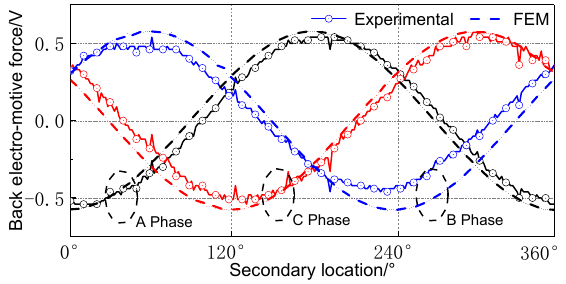
Figure 16. No-load back EMF.